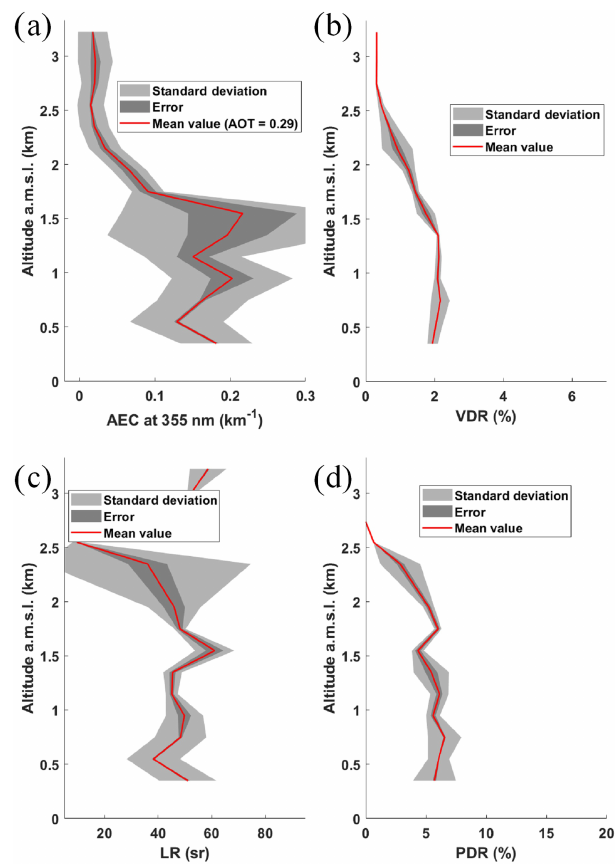
Figure 5. Vertical profiles derived from ALiAS during flight 07 on 31 January 2020 at 15:00–18:45UTC of (a) the aerosol extinc- tion coefficient (AEC), (b) the volume depolarization ratio (VDR), (c) the lidar ratio (LR), and (d) the particle depolarization ratio